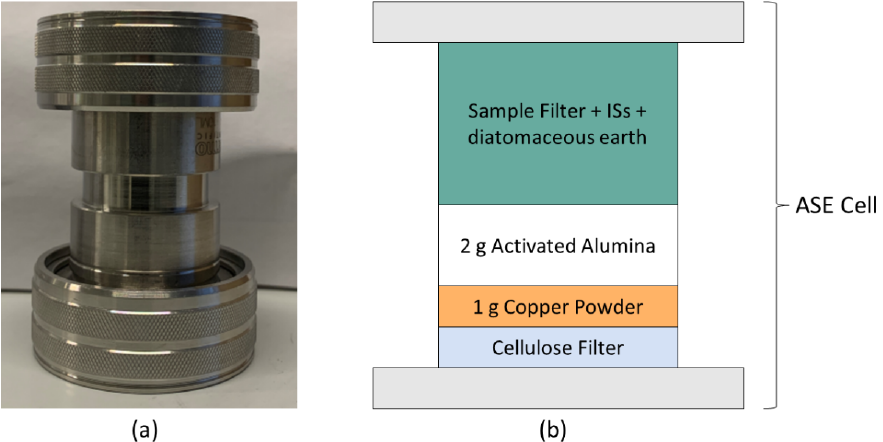
Figure 2. Description of the ASE extraction cell. ( a ) Extraction cell used for the ASE procedure. ( b ) Illustration of how the different layers of clean-up powders and sample are placed in the ASE extraction cell.